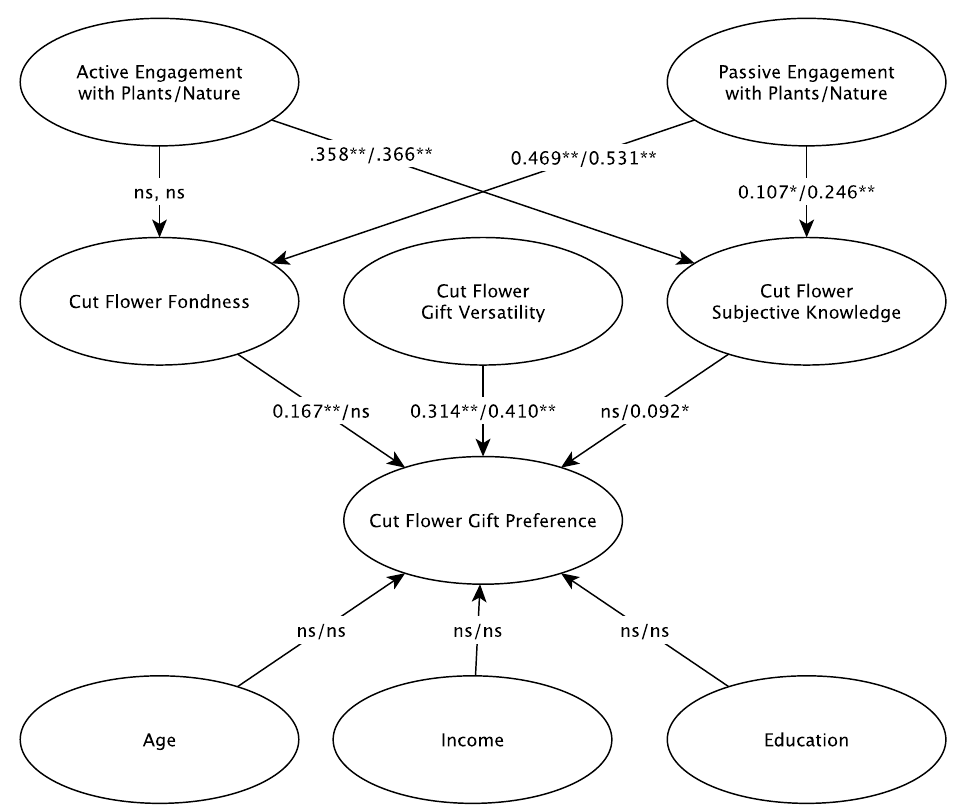
Figure 2. Conceptual framework including relationships between the variables tested on male and female sub ‐ groups. Notes: *Significant at p<0.05; **Significant at p<0.01; ns: not significant; Results: female/male